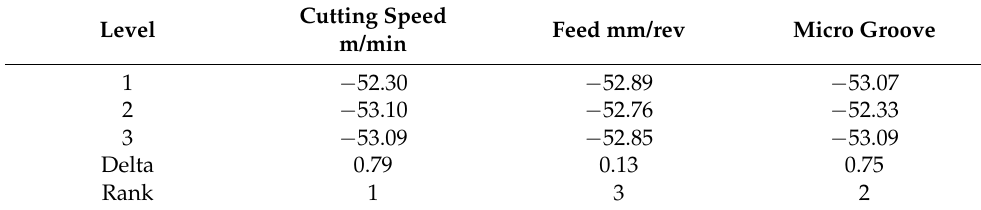
Table 4. Cutting temperature: mean response.